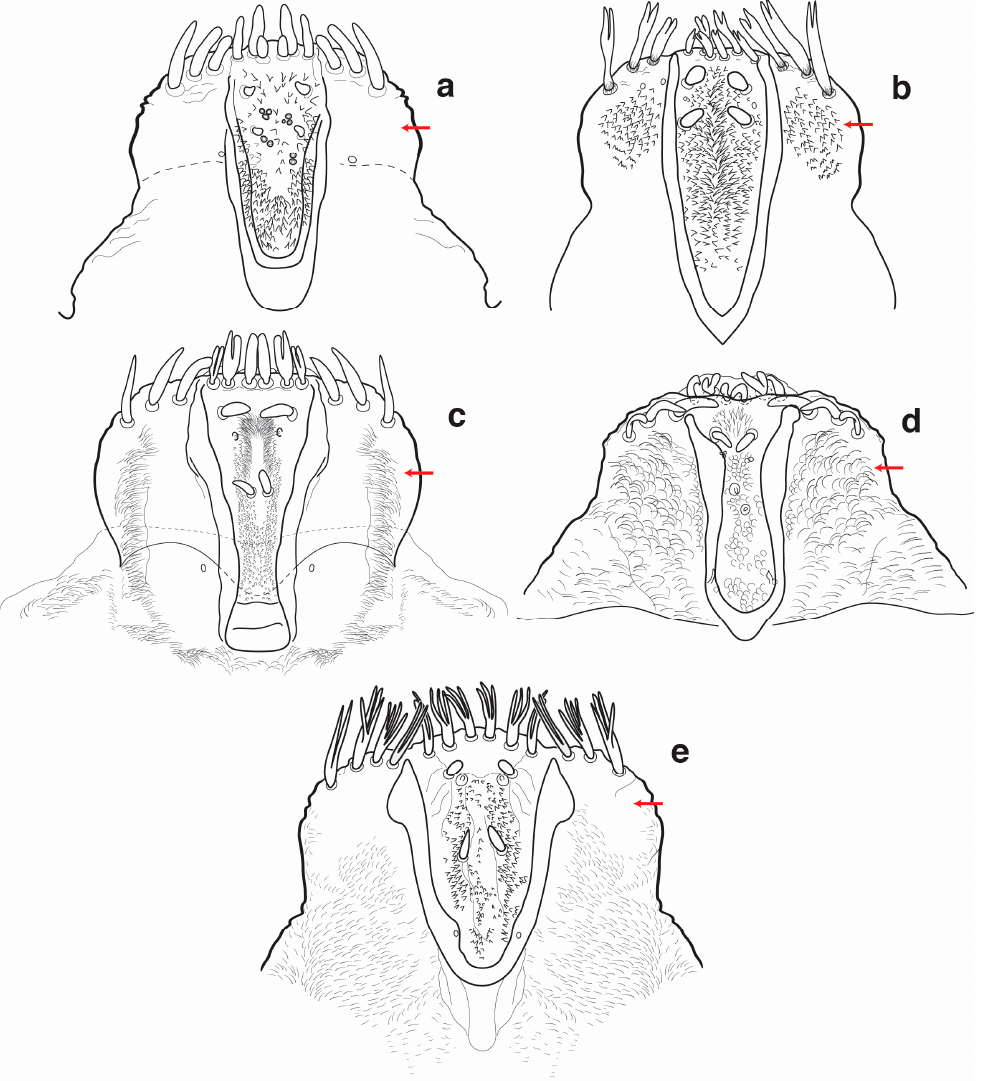
Figure 20. Epipharynx, larva: ( a ) Diocalandra ; ( b ) Eugnoristus ; ( c ) Metamasius ; ( d ) Trochorhopalus ; and ( e ) Sipalinus . 7. Lateral microsetae/asperites of epipharynx ( Rhynchophorus and Cyrtotrachelus have large